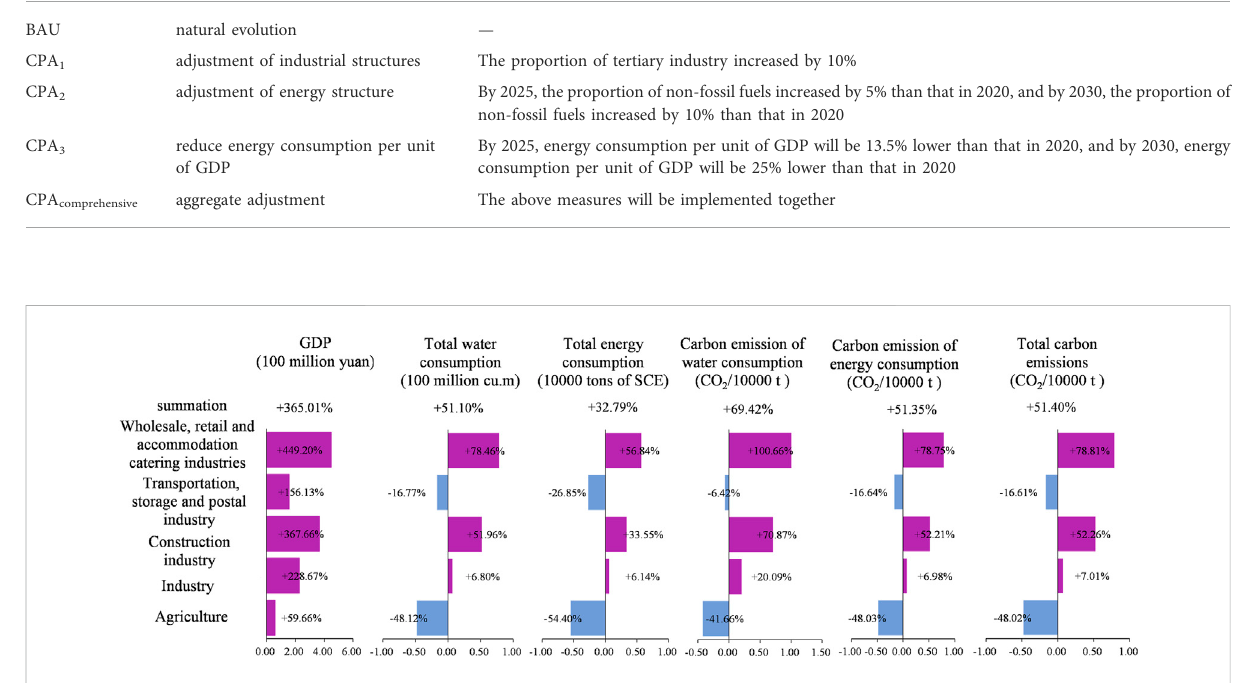
FIGURE 5 GDP, water resources, energy and carbon emissions of various industries in Taiyuan from 2005 to